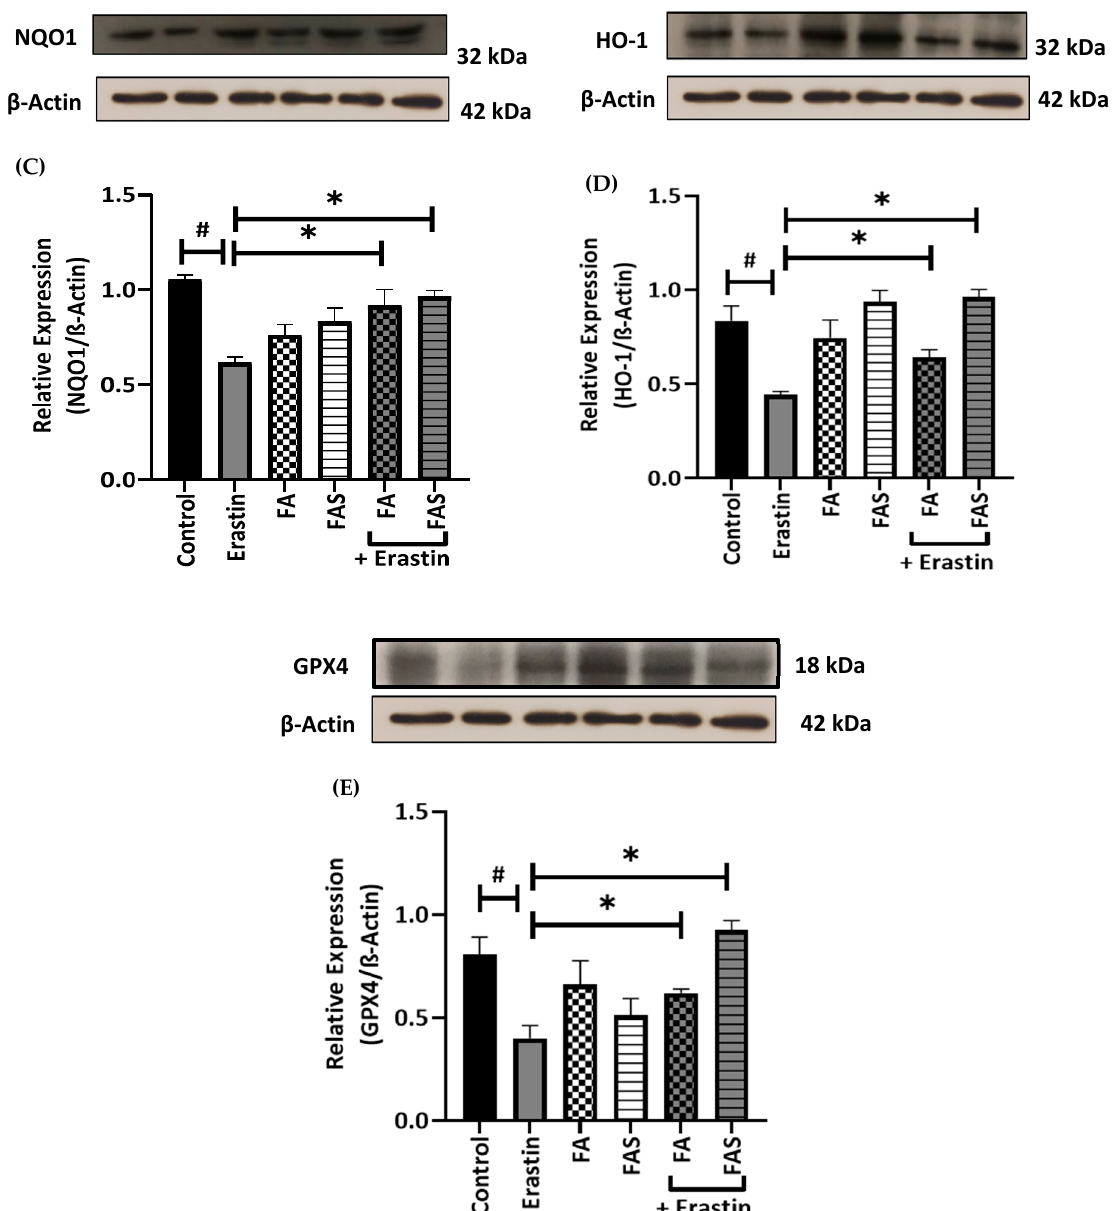
Figure 5. FA and FAS activate the Nrf2 pathway. Cells were treated with 20 µ M of erastin in the absence and presence of 20 µ M of ferulic acid (FA) or ferulic acid 4-O-sulfate disodium salt (FAS) for 24 h. Total cell lysates were prepared and subjected to Western blot analysis to monitor the expression levels of Nrf2 ( A ) and its downstream antioxidant proteins, including GCLC ( B ), NQO1 ( C ), HO-1 ( D ) and GPX4 ( E ). GAPDH and β -Actin served as internal controls. The quantitative results of the protein expressions in pancreatic β cells were determined by greyscale analysis using the ImageJ software. All the values are expressed as the mean ± SEM. # p < 0.05 control vs. treatment groups; * p < 0.05 erastin only vs. treatment groups. One-way ANOVA, Tukey’s post hoc test.